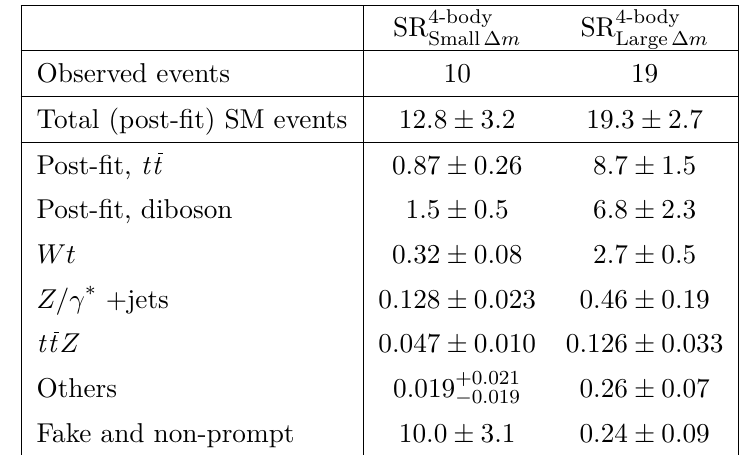
Table 18 . Four-body selection. Observed event yields and background fit results for SR 4-body and SR 4-body . The ‘Others’ category contains the contributions from V V V , tt t , tttt , tt W , Large ∆ m tt WW , tt WZ , tt H , and tZ . Combined statistical and systematic uncertainties are given. The individual uncertainties can be correlated, and do not necessarily add up in quadrature to the total background